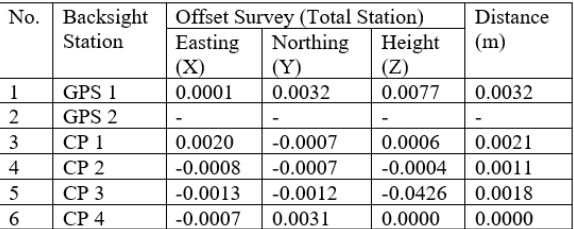
Table 3.1 Terrestrial Laser Scanning backsight error